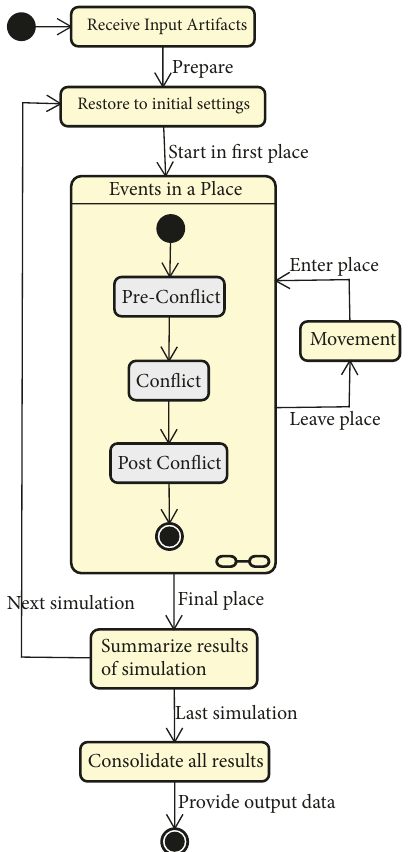
Figure 3: Simulation Engine